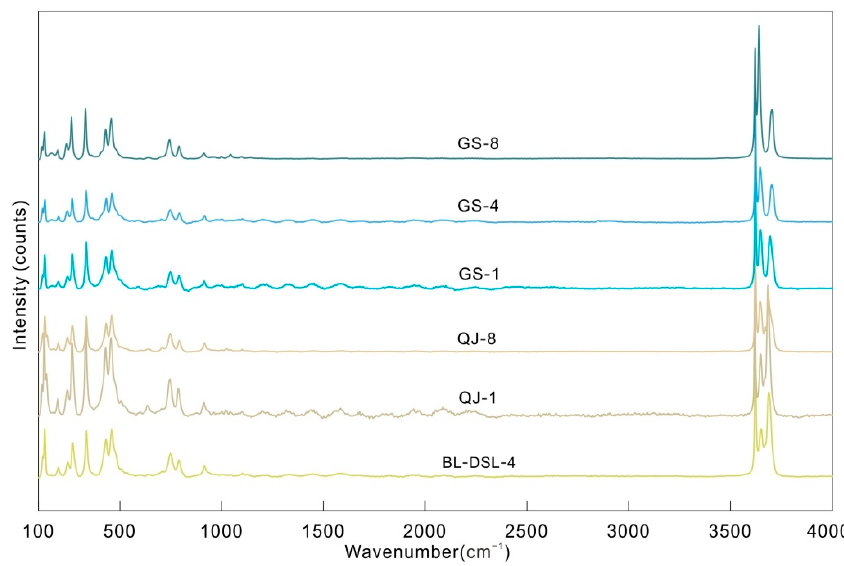
Figure 4. Raman spectra of the kaolinite and dickite samples.